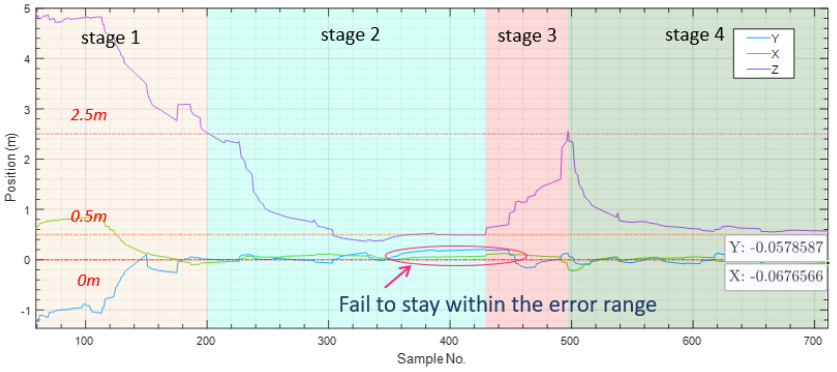
Figure 10. Estimated positions from the camera, UAV auto-landing in the field with mild